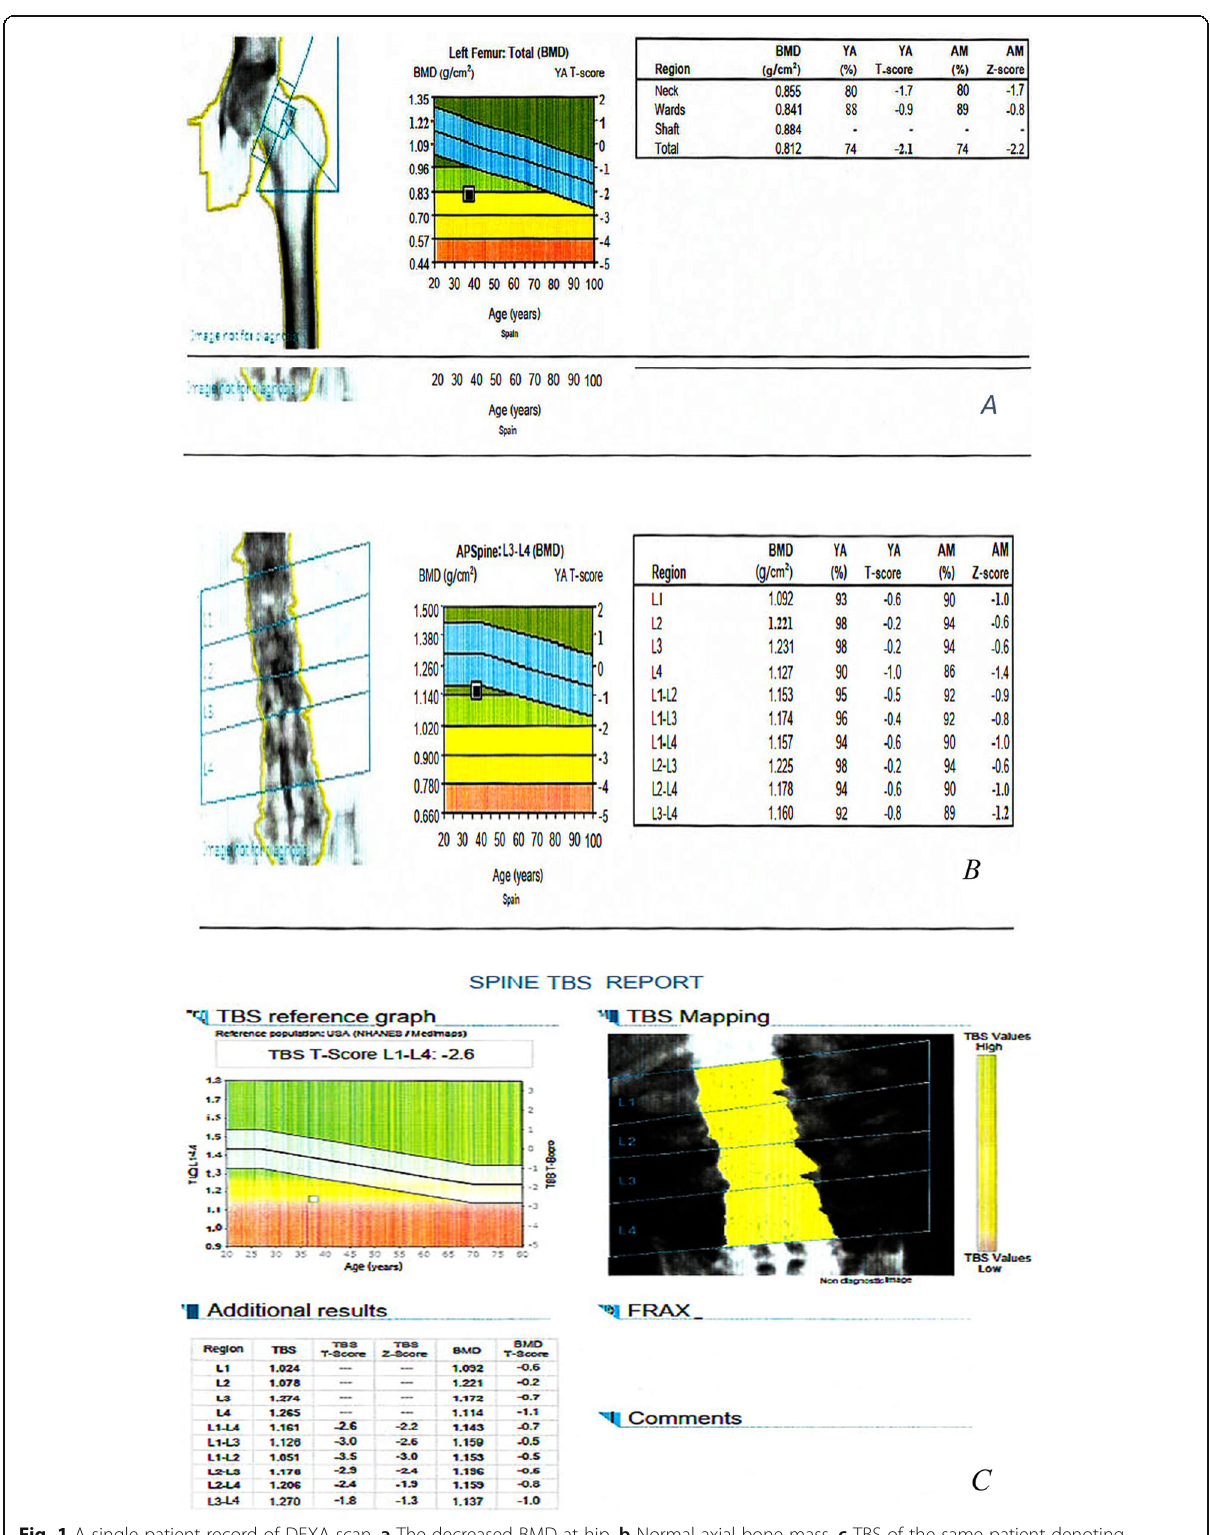
Fig. 1 A single patient record of DEXA scan. a The decreased BMD at hip. b Normal axial bone mass. c TBS of the same patient denoting degraded bone